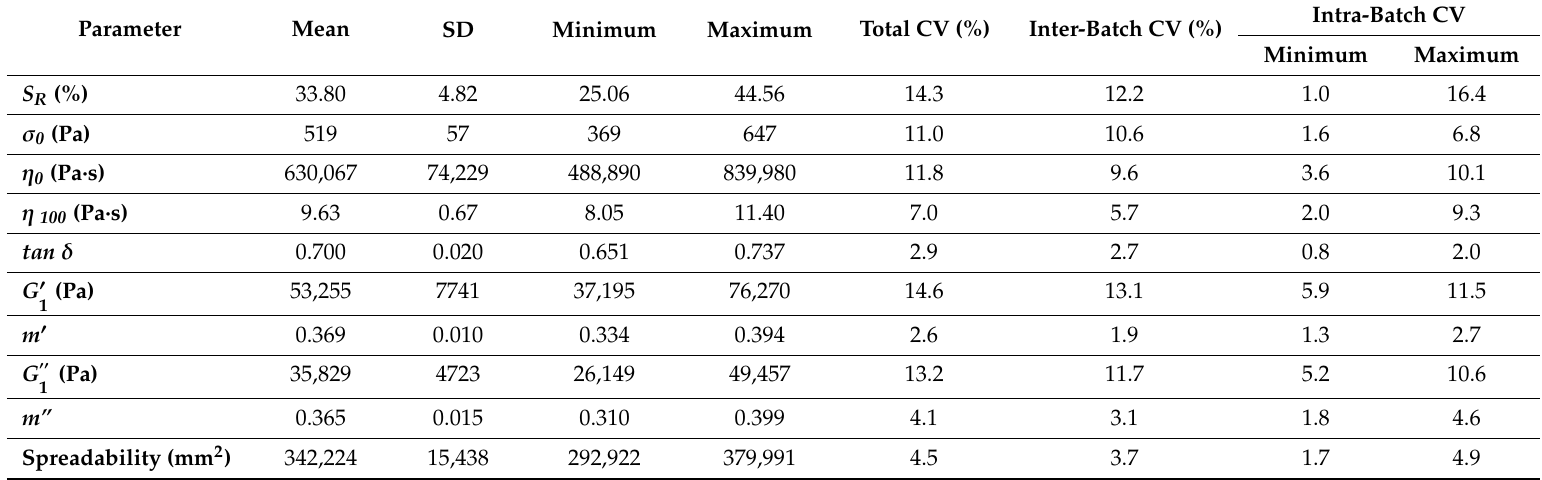
Table 1. Physical parameters (rheological properties and spreadability) of 10 batches (12 replicates each) of reference formulation. Parameter Mean